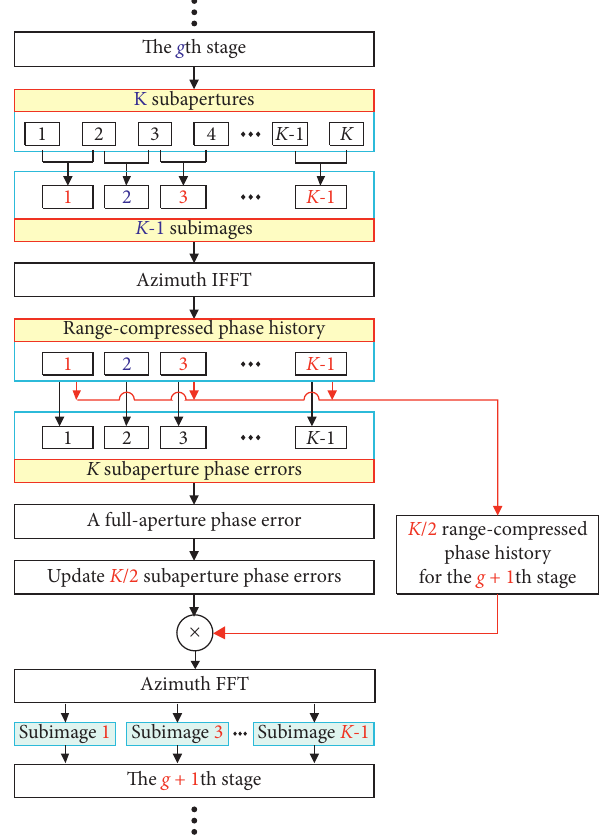
Figure 5: Block diagram of OSF in the modified